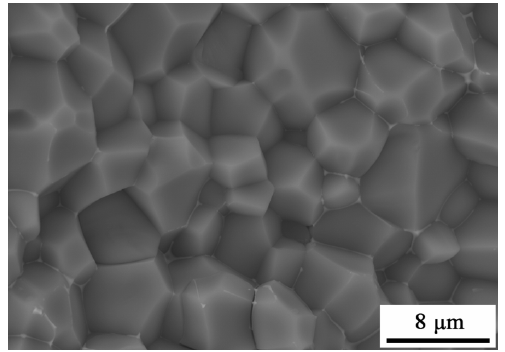
Fig. 7 Microstructure of the dense AlN ceramic fracture (backscattered electron image).